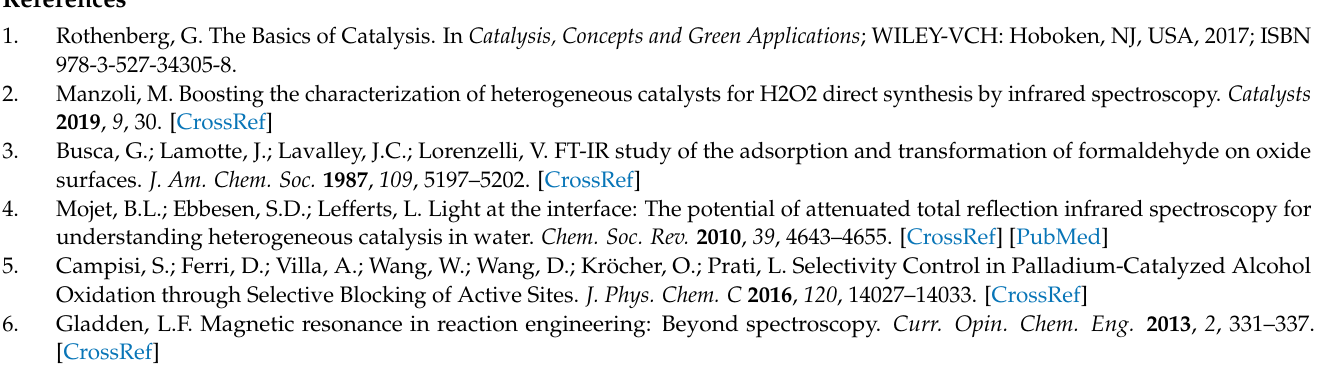
Figure S5, Figure S6, Figure S7, Figure S8 and Figure S9: title Figure S1. Analysis of Benzaldehyde in p-xylene (T1bulk). Pseudo-2D NMR experiment for T1 measurement using inversion recovery sequence (top) and analysis of the inversion recovery curve for the aldehydic carbon (bottom).; Figure S2. Analysis of Benzaldehyde in p-xylene in presence of GNP. Pseudo-2D NMR experiment for T1 measurement using inversion recovery sequence (top) and analysis of the inversion recovery curve for the aldehydic carbon (bottom); Figure S3. Analysis of Benzaldehyde in p-xylene in presence of Pd-GNP. Pseudo-2D NMR experiment for T1 measurement using inversion recovery sequence (top) and analysis of the inversion recovery curve for the aldehydic carbon (bottom); Figure S4. Analysis of Octanal in p-xylene (T1bulk). Pseudo-2D NMR experiment for T1 measurement using inversion recovery sequence (top) and analysis of the inversion recovery curve for the aldehydic carbon (bottom); Figure S5. Analysis of Octanal in p-xylene in presence of GNP. Pseudo-2D NMR experiment for T1 measurement using inversion recovery sequence (top) and analysis of the inversion recovery curve for the aldehydic carbon (bottom); Figure S6. Analysis of Octanal in p-xylene in presence of Pd-GNP. Pseudo-2D NMR experiment for T1 measurement using inversion recovery sequence (top) and analysis of the inversion recovery curve for the aldehydic carbon (bottom); Figure S7. Analysis of Octanal in CDCl3 (T1bulk). Pseudo-2D NMR experiment for T1 measurement using inversion recovery sequence (top) and analysis of the inversion recovery curve for the aldehydic carbon (bottom); Figure S8. Analysis of Octanal in CDCl3 in presence of GNP. Pseudo-2D NMR experiment for T1 measurement using inversion recovery sequence (top) and analysis of the inversion recovery curve for the aldehydic carbon (bottom); Figure S9. Analysis of Octanal in CDCl3 in presence of Pd-GNP. Pseudo-2D NMR experiment for T1 measurement using inversion recovery sequence (top) and analysis of the inversion recovery curve for the aldehydic carbon